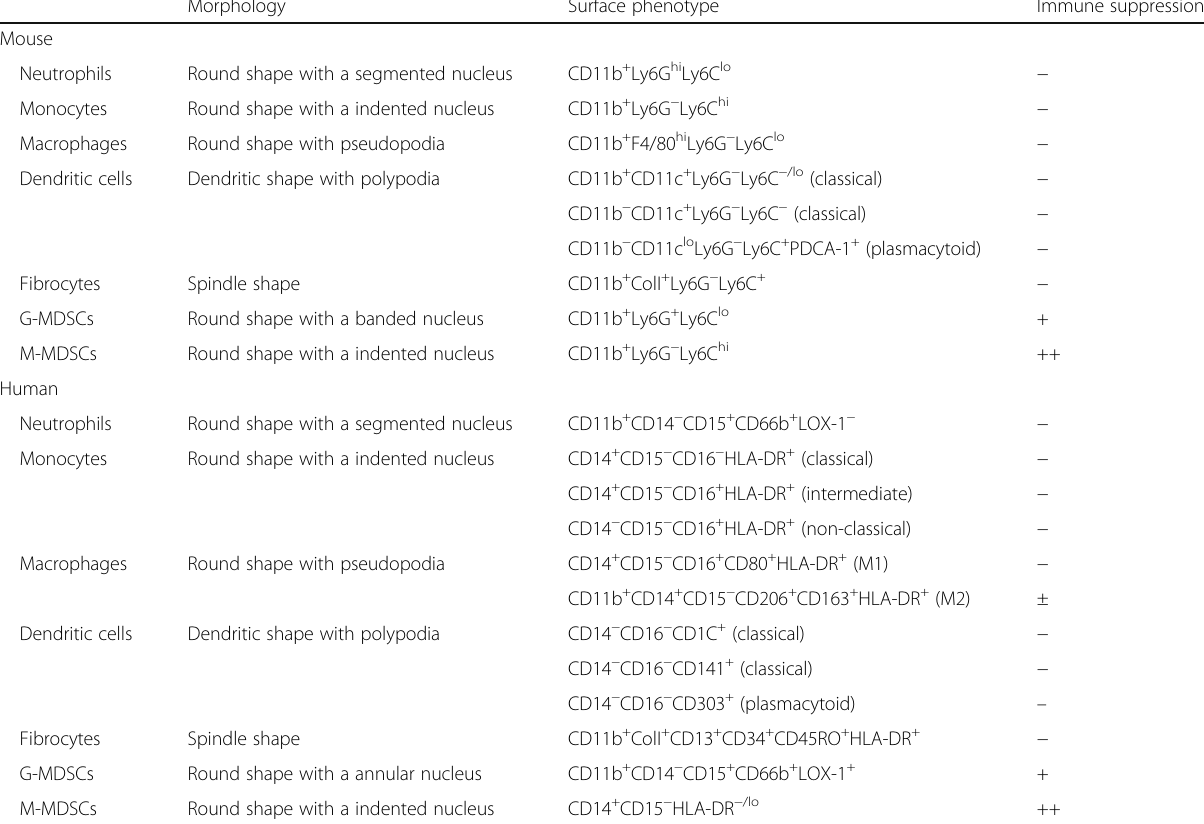
Table 1 Comparisons of morphology, phenotype, and function between myeloid-derived cells Morphology Surface phenotype Immune suppression Mouse Neutrophils Round shape with a segmented nucleus